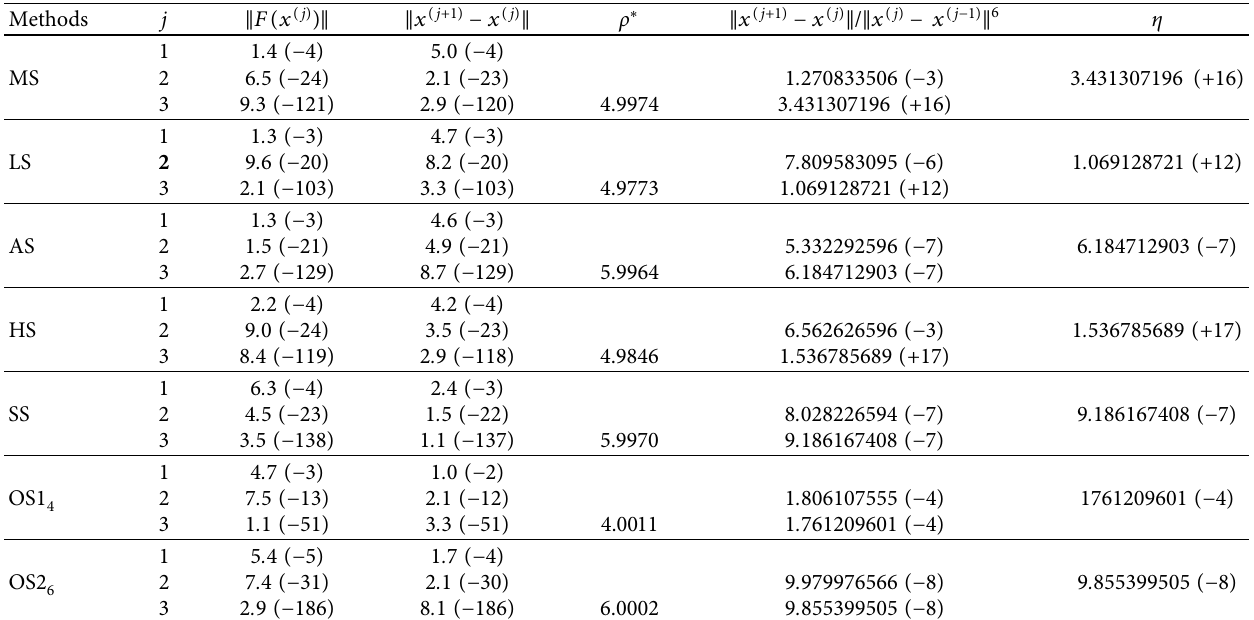
Table 1: Convergence behavior of different methods on differential equation (27).